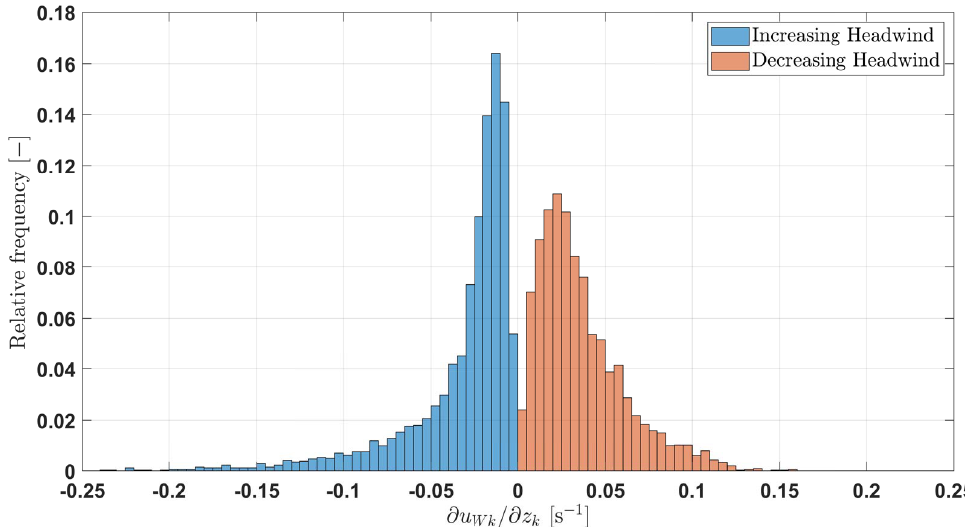
Figure 5. Relative Frequency distribution of wind shear from the altitude of 40 m to the altitude of the LLJ maximum at the Clausthal-Zellerfeld site. All 3500 data sets of 10min fulfilling the LLJ criteria are included in the statistics.